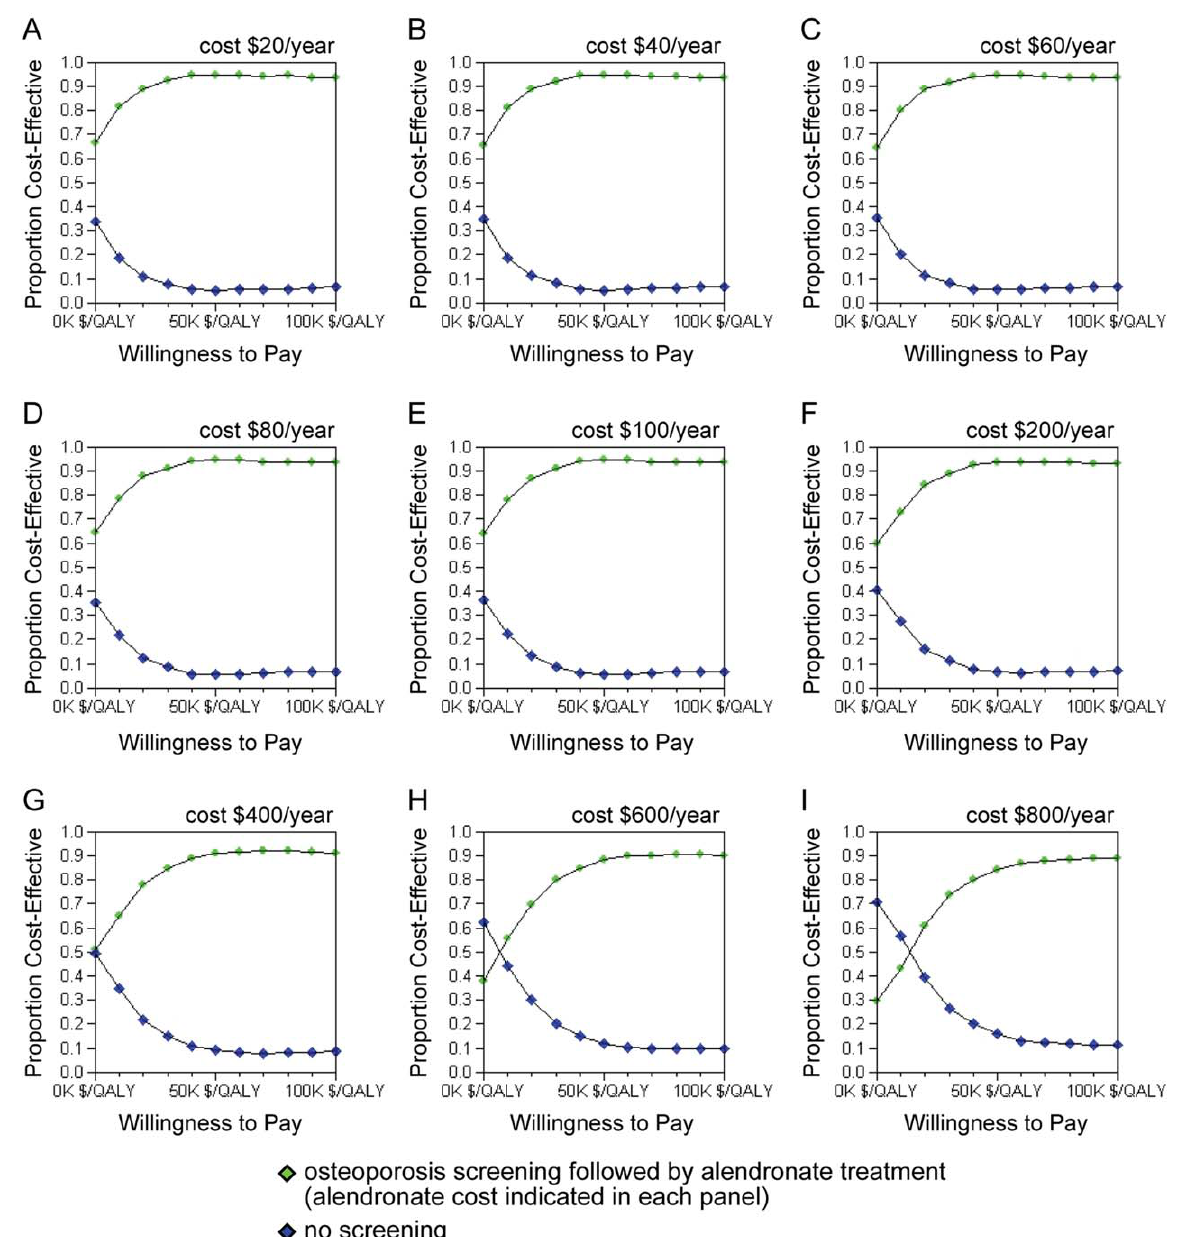
Figure 2. Probabilistic Sensitivity Analysis Cost-Effectiveness Acceptability Curves.